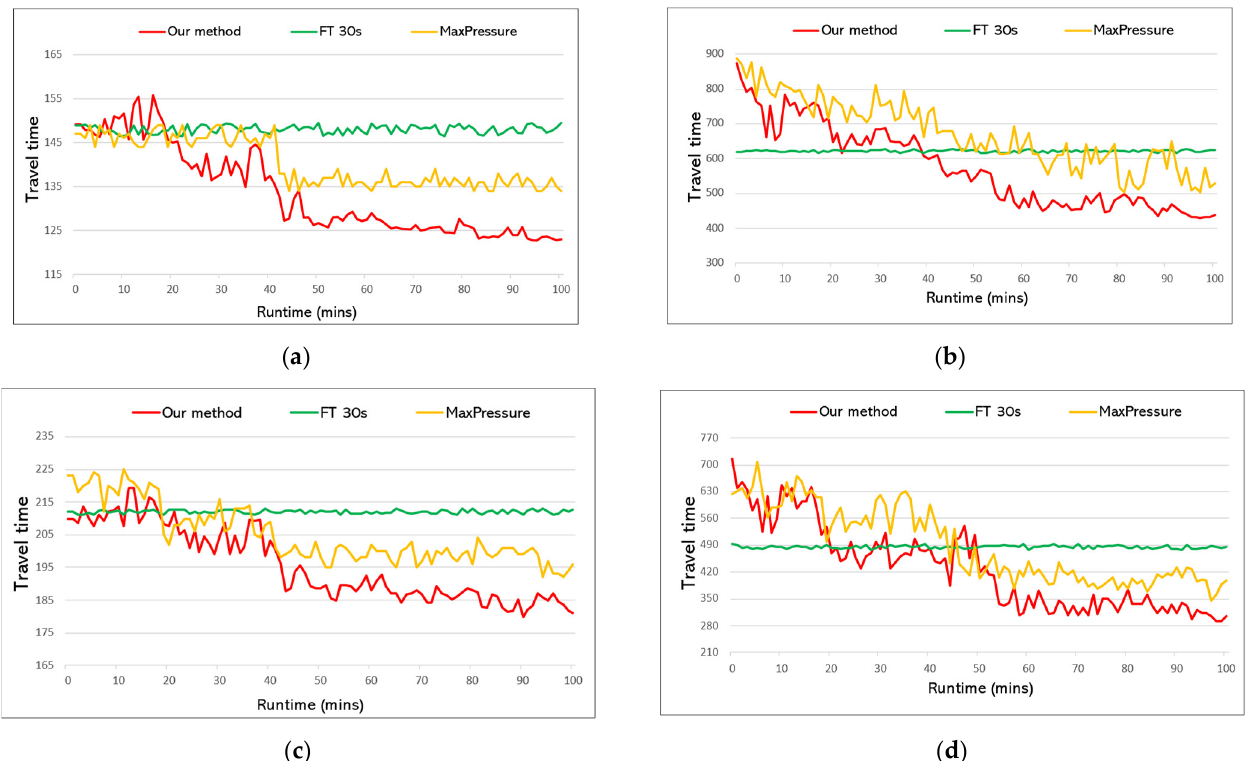
Figure 7. Performance comparison between proposed Biased Pressure (denoted as ‘Our method’), MaxPressure, and Fixed-time 30 s (‘FT 30 s’) using RN 3 × 3 and RN 4 × 8 road networks with four figurations of traffic volume. Our method shows better performance in each configuration. ( a ) × with Config 1. ( b ) × with Config 3. ( c ) × with Config 4. ( d ) × with Config 2. In each configuration, our method outperforms the existing MaxPressure method.